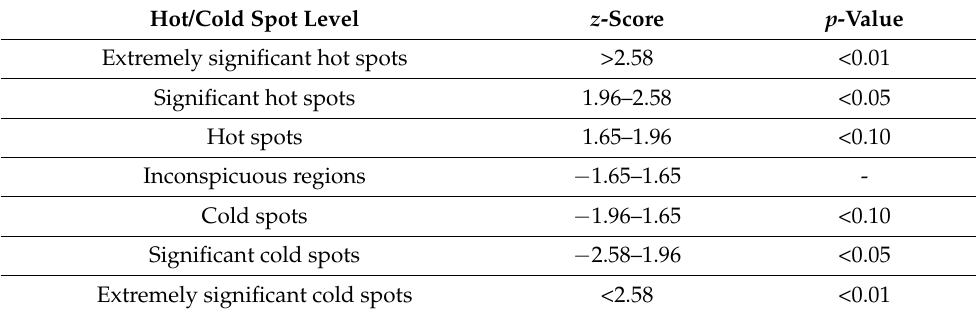
Table 2. The hot/cold spots confidence level.